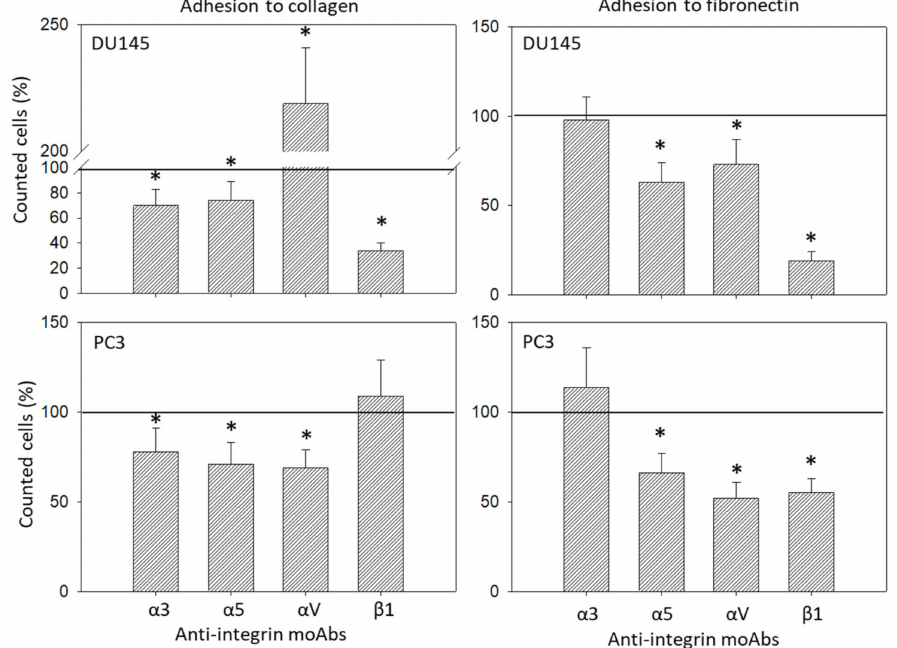
Figure 12. Adhesion modulation of DU145 and PC3 through monoclonal antibodies against α 3, α 5, α V, or β 1 (left: adhesion to collagen; right: adhesion to fibronectin). Controls remained untreated. * indicates significant difference to untreated controls ( n =